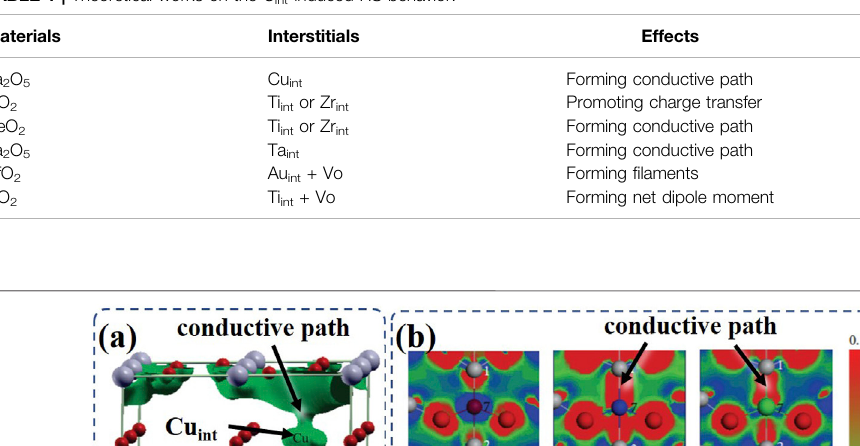
TABLE 1 | Theoretical works on the C int -induced RS behavior.